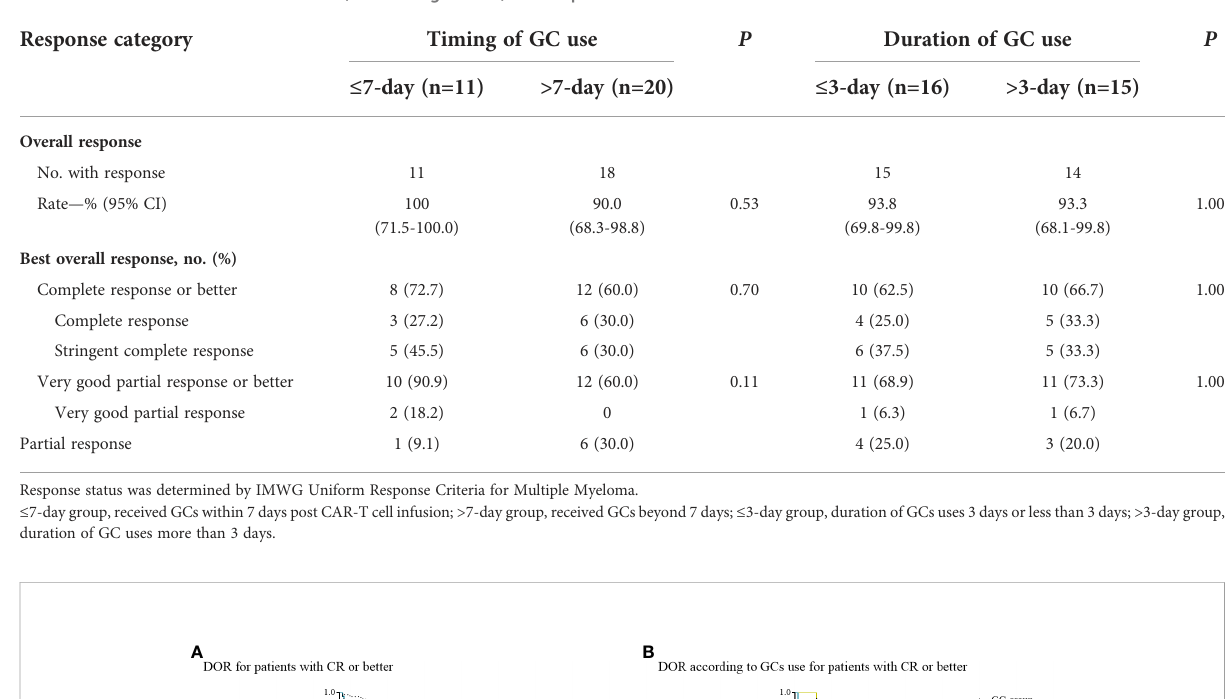
TABLE 3 Association between duration, the timing of GCs, and